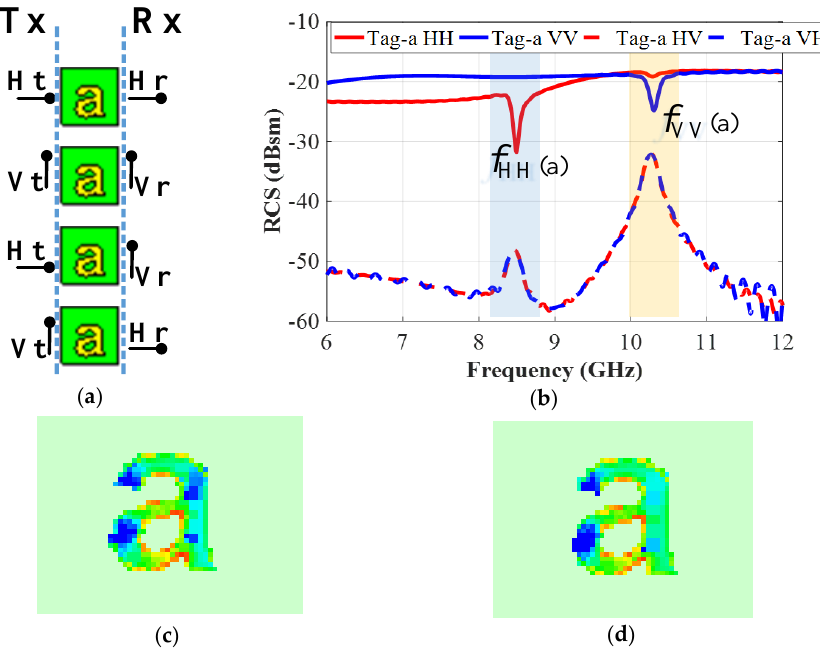
Figure 4. Simulation of the electromagnetic response of the “letter-a” resonator as a function of polarization: ( a ) Different polarizations setups (HH/VV/HV/VH); ( b ) Observed signature frequencies in co(HH/VV)- and cross(HV/VH)-polarizations; ( c ) Surface current at fHH (a) when tag is exposed to horizontally polarized plane wave (Ht) and probe record signals in both polarizations; ( d ) Surface current at fVV ( a ) when tag is exposed to vertically polarized plane wave (Vt) and probe record signals in both polarizations.